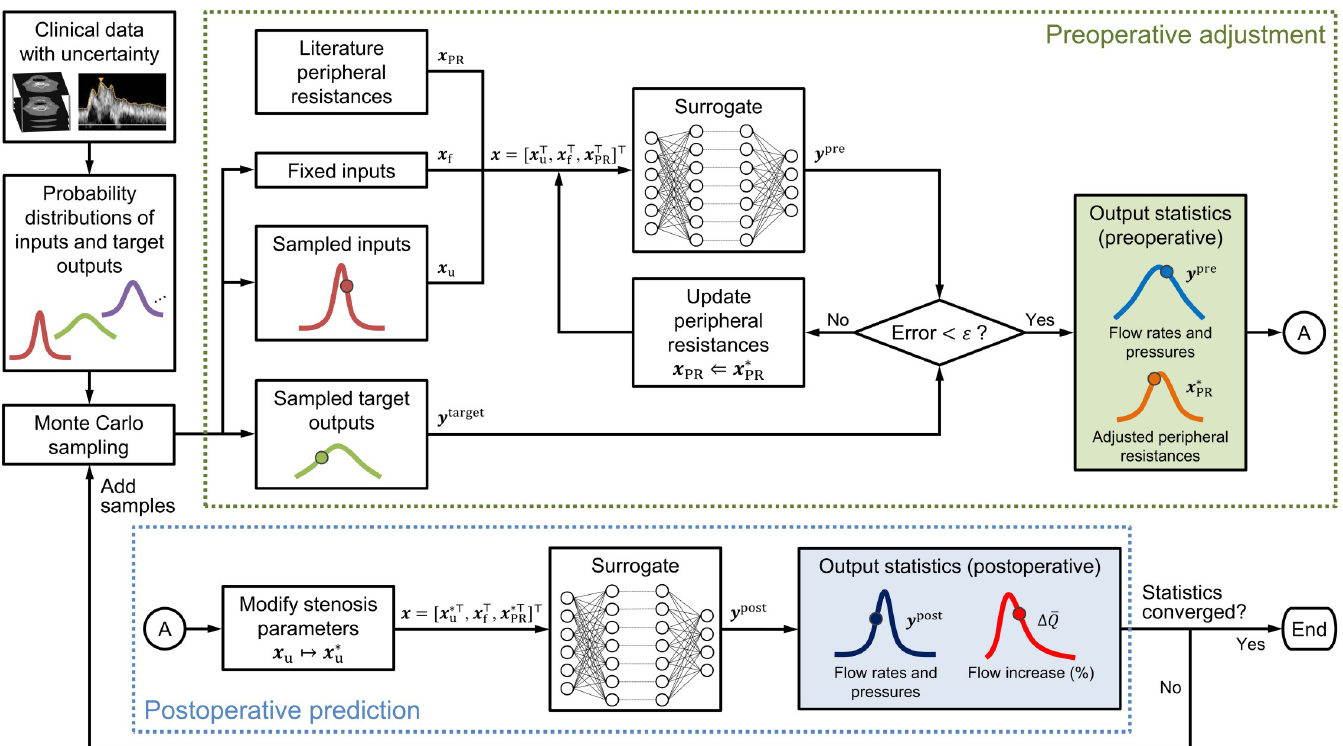
Fig 4. Flowchart for uncertainty quantification using the Monte Carlo method. For each Monte Carlo sample, peripheral resistances of the circle of Willis and the scaling factor for total peripheral resistance were adjusted (“preoperative adjustment”), followed by a virtual dilation of the stenosis to predict the cerebral circulation immediately after the surgery (“postoperative prediction”). The number of samples was increased sequentially until the statistics converged. The method can be applied to any probability density function; however, we assume a uniform distribution in this study. Additional details regarding the algorithm are provided in S2 Appendix.